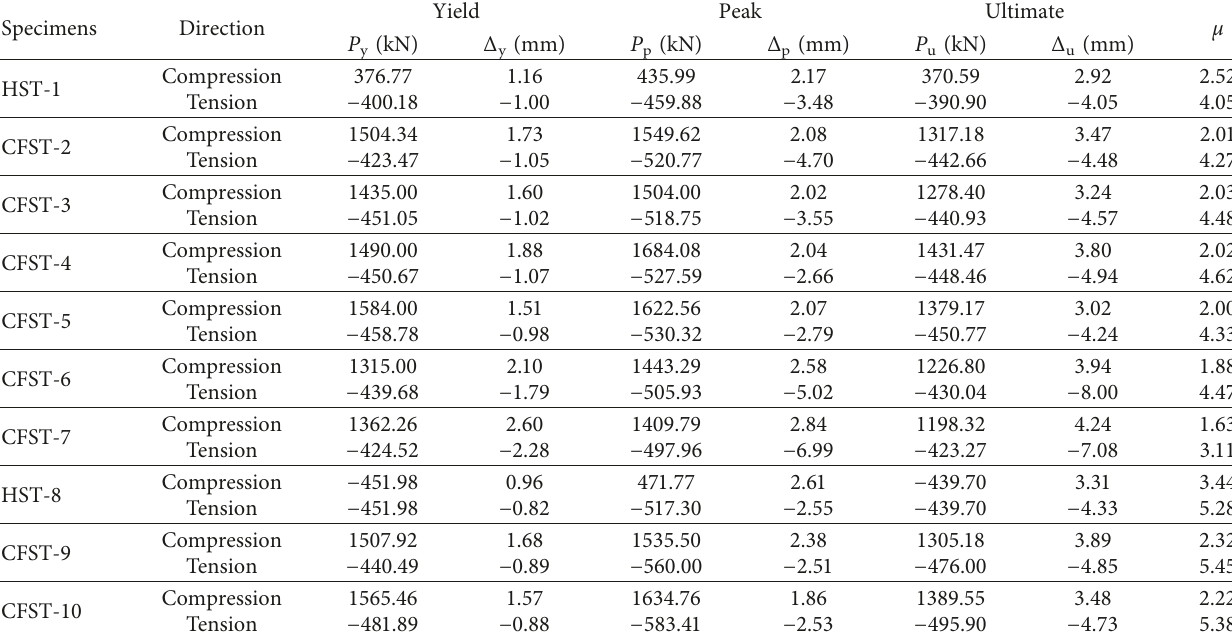
Table 3: Experimental